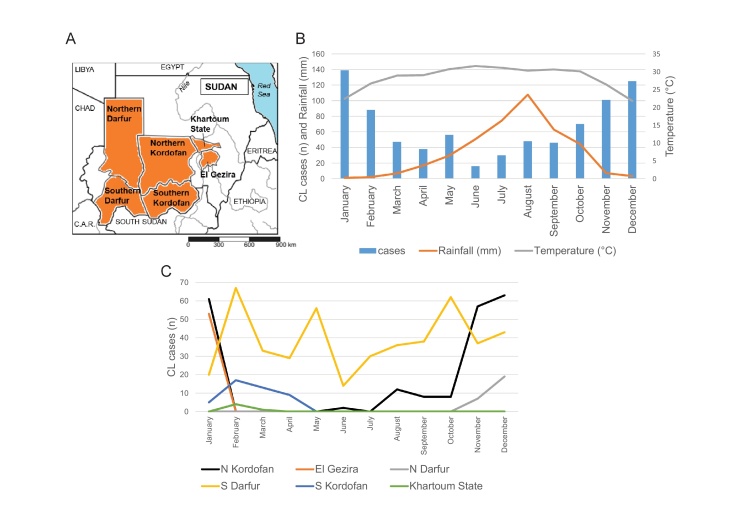
KalaCORE data. (A) Geographical sources of data. (B) KalaCORE cutaneous leishmaniasis data for 2016 (blue bars), with temperature and rainfall data for 2015 overlaid, indicating a decrease in case reports with rising rainfall. (C) KalaCORE individual state data showing that Southern Darfur had additional peaks of case reports in May and October.